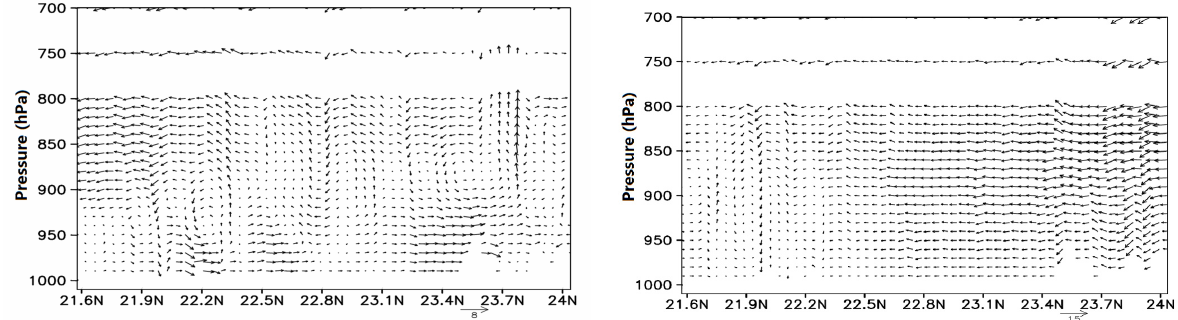
Fig. 11. Vertical cross-sections of WRF modeled wind (ms − 1 ) along 113.2 ◦ E (a) at 03:00 LST on 13 July and (b) at 03:00 LST on 14